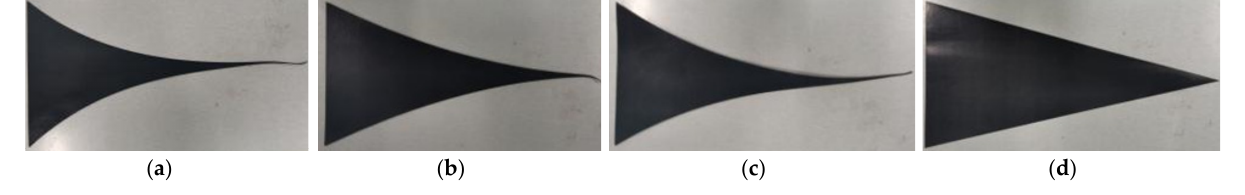
Figure 5. Four kinds of fishtail flakes with different stiffness change rates. ( a ) Rubber tail slice cut according to the curve y = (7 − 0.25 x ) 4 /343. ( b ) Rubber tail slice cut according to the curve y = (7 − 0.25 x ) 3 /49. ( c ) Rubber tail slice cut according to the curve y = (7 − 0.25 x ) 2 /7. ( d ) Rubber tail slice cut according to the curve y = (7 − 0.25 x ).